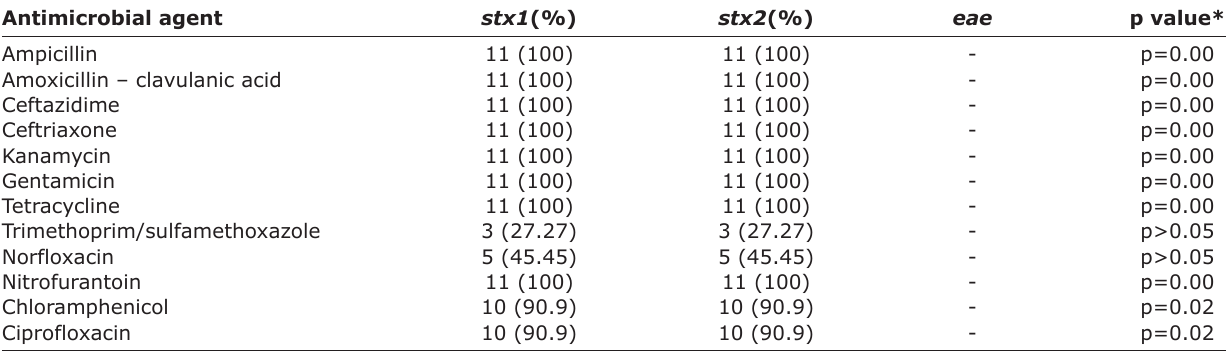
Table-4: Pairwise statistical associations between antimicrobial agents and virulence genes. Antimicrobial agent stx1 (%)